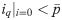
A. Changes in profits and revenue when iqq > 0 and iq|i=0<p¯. B. Changes in profits and revenue when iqq > 0 and iq|i=0≥p¯.